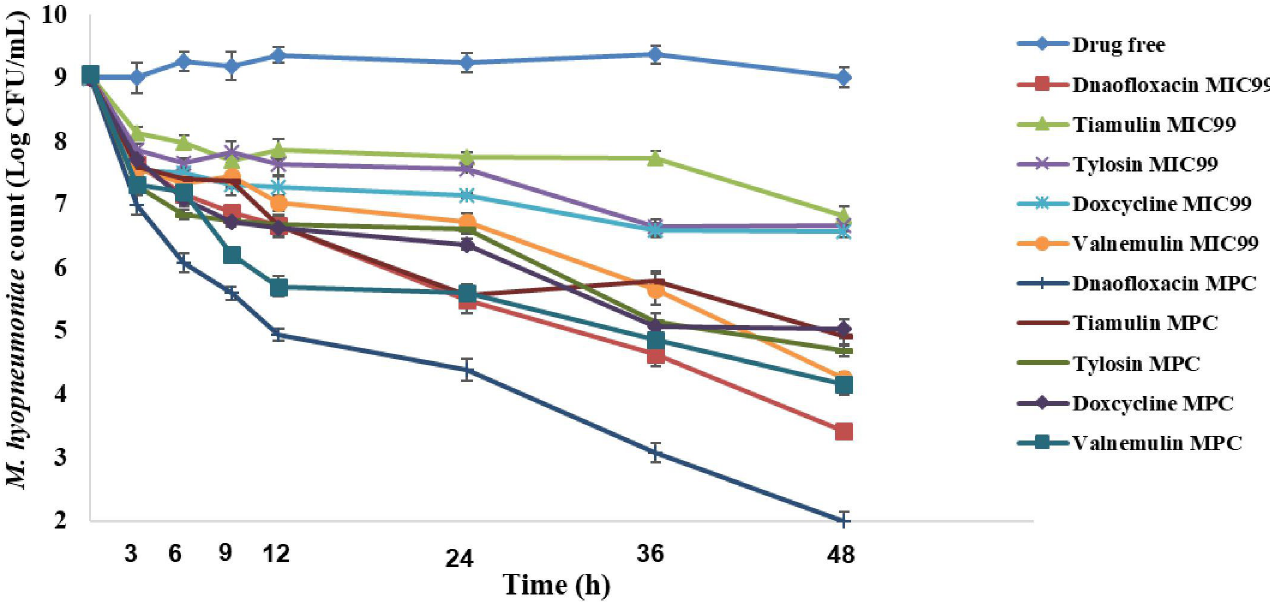
Fig 4. M . hyopneumoniae killing curves at the minimal concentration inhibiting colony formation by 99% (MIC 99 ) and at the mutant prevention concentration (MPC) with an inoculum of 10 9 CFU/mL.